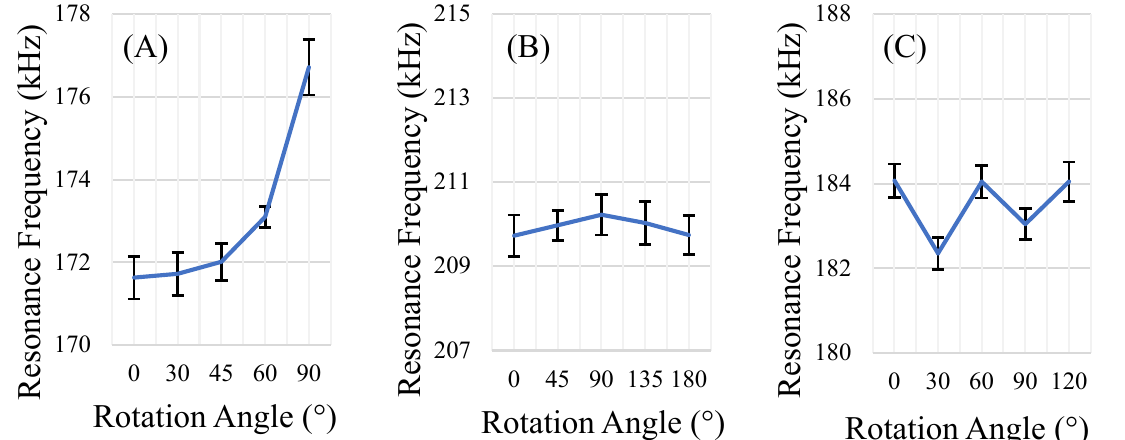
Figure 8. Changes in the sensor’s resonance frequency at varying directions of magnetic field. Three shapes of sensors were evaluated: rectangular ( A , 12.7 mm × 5 mm), square ( B , length = 12.7 mm), and equilateral triangle ( C , base = 14.6 mm, height = 12.7 mm). Angular increments were selected based on the rotational symmetry of the shape. ( n = 5; error = ± standard deviation) .